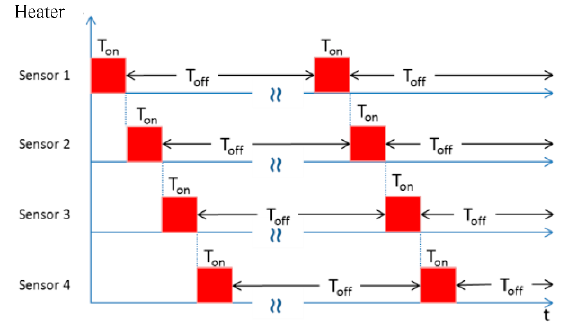
Figure 2. Sequential behavior of the heaters in the sensor